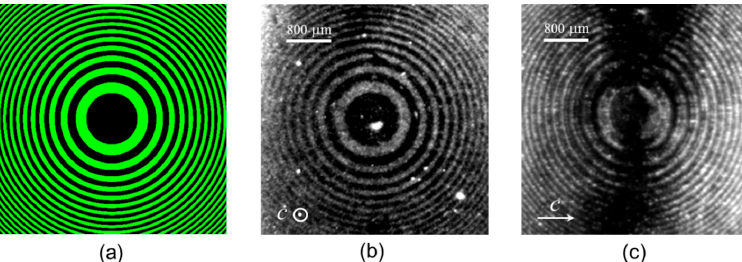
Figure 4. Light pattern illuminating the substrate ( a ), and corresponding CaCO 3 micro ‑ particle (average diameter ~2 µm) patterns for z ‑ cut ( b ) and x ‑ cut ( c ) LiNbO 3 :Fe substrates. The direction of the crystal c ‑ axis is indicated in ( b , c ). Reprinted with permission from Martínez ‑ Muñoz et al. Opt. Mater. Express 2015 , 5 , 1137. Copyright 2015 Optical Society of American (reference [29]).